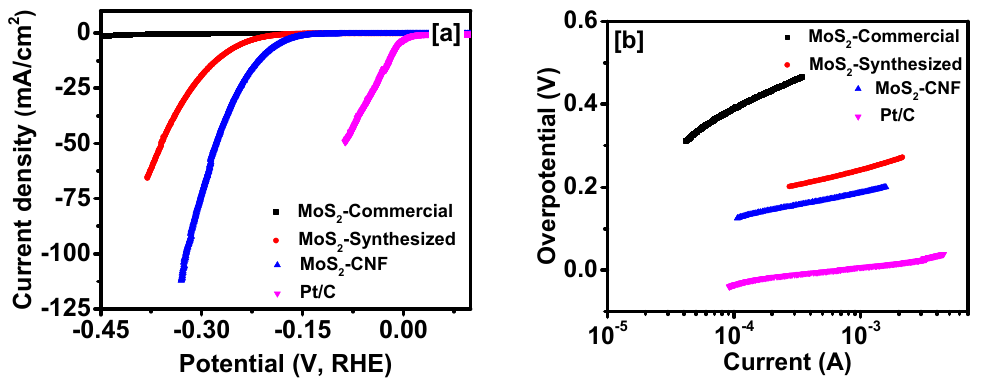
Figure 4. ( a ) Polarization curves; and ( b ) Tafel slopes for various MoS 2 samples.